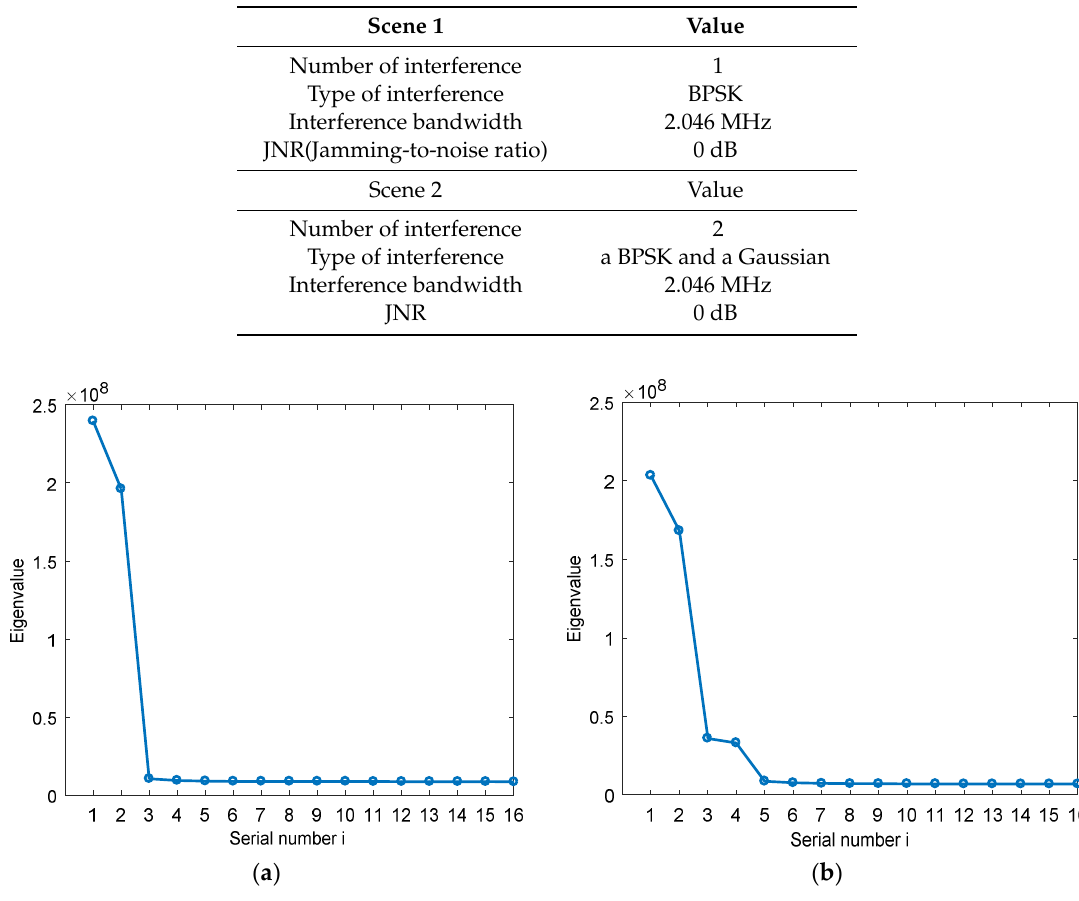
Figure 5. The distribution of the eigenvalues. ( a ) The distribution of the eigenvalues in scene 1; ( b ) The distribution of the eigenvalues in scene 2.